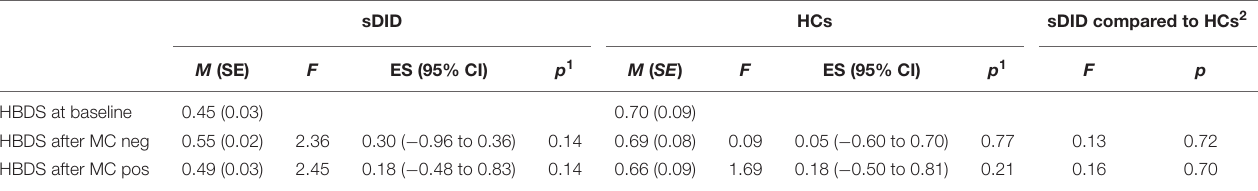
TABLE 3 | Within-group courses of the heartbeat detection scores for sDID patients and HCs (left) and between-group differences calculated using ANOVAs, controlled for initial heartbeat detection score value (right). sDID HCs sDID compared to HCs 2 M (SE) F ES (95% CI)